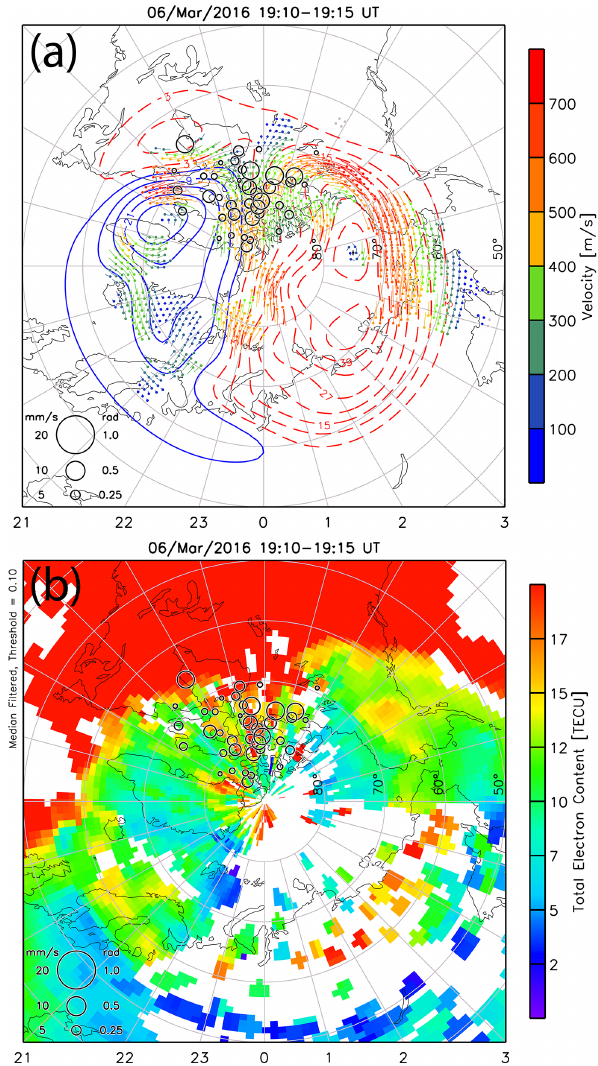
Figure 4. Panel (a) depicts the SuperDARN ionospheric convection and potential maps showing expanded convection zone and (b) the GPS TEC as a function of magnetic latitude and magnetic local time (MLT). The CHAIN GPS IPPs at 350km shown as circles scaled by the GPS phase variation values, σ (cid:56) , are